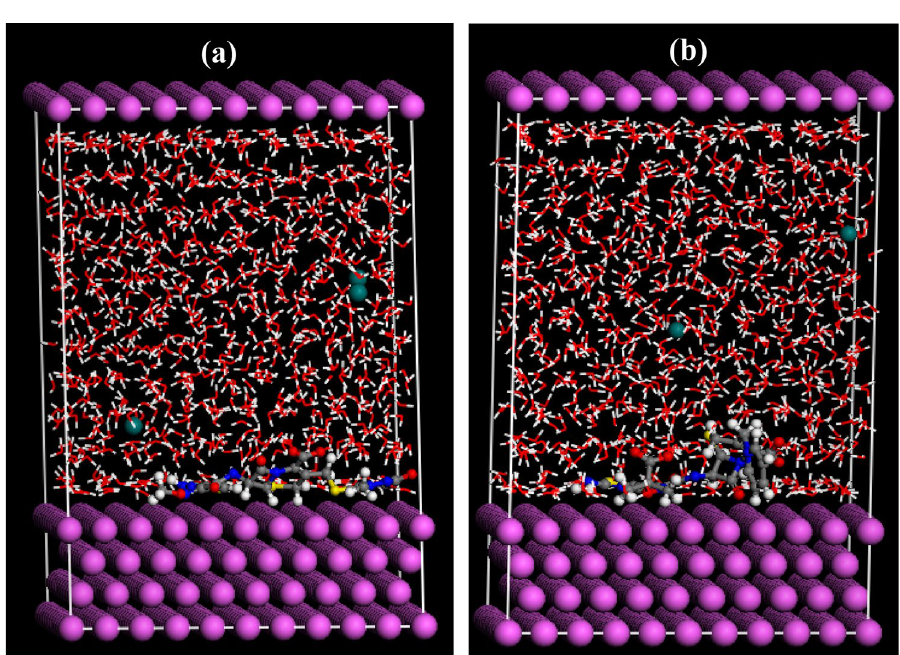
Figure 16. MD Snapshots of the most stable low energy configuration for the adsorption of Cefx and Cefz drugs on Al (111)/950H 2 O interface ( a ) Cefx and ( b )